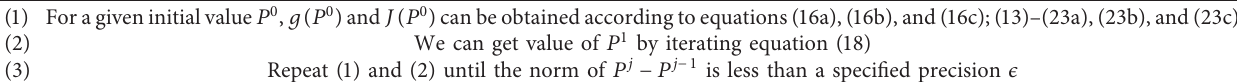
Table 1: The procedure for the iteration of the fixed point P .